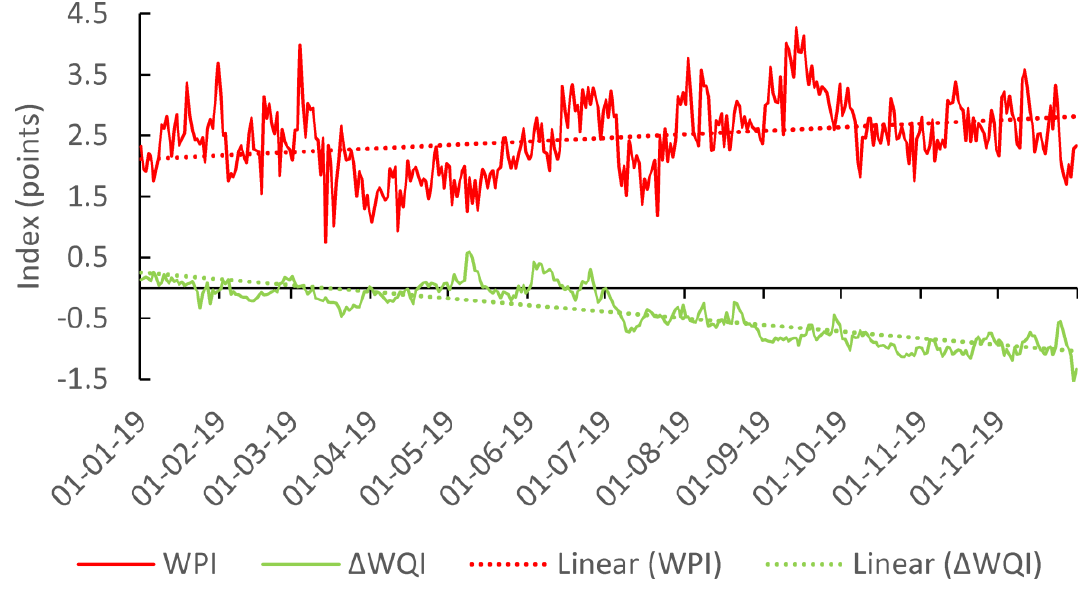
Figure 11. Comparison of the temporal evolution (daily data) of WPI (data from WWTP) and ∆ WQI (di ff erence between downstream and upstream values of Suceava River